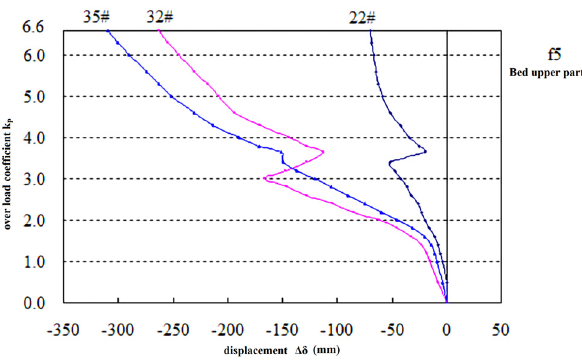
Figure 6: The relative displacement Δ δ – K p curve of F5 dam abutment position.